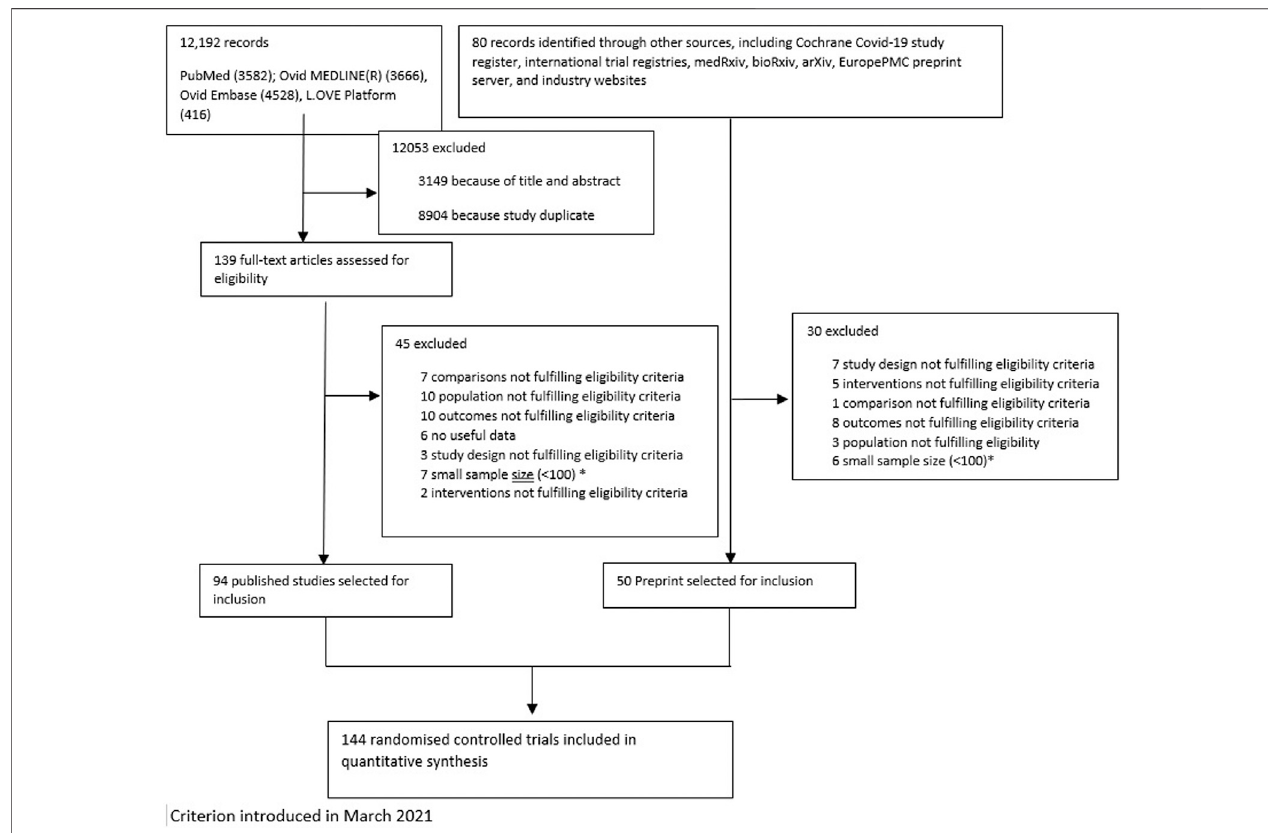
FIGURE 1 | Flow chart reporting the results of the search strategy.